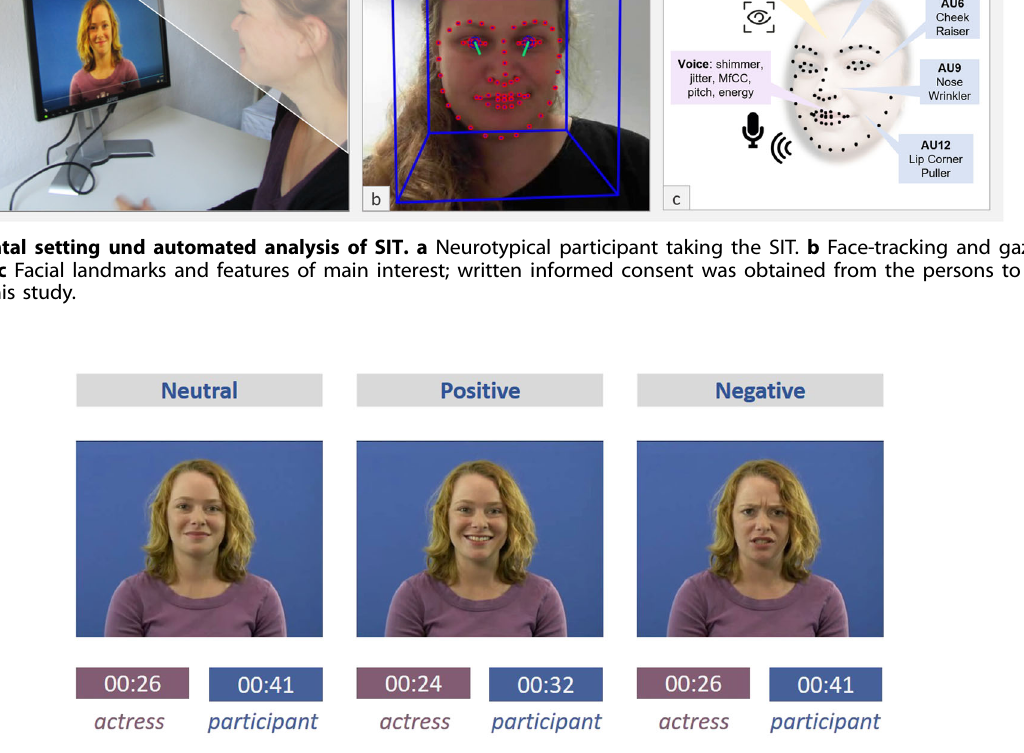
Fig. 7 Timing for each excerpt of SIT. Written informed consent was obtained from the person to have her photos used in this study.